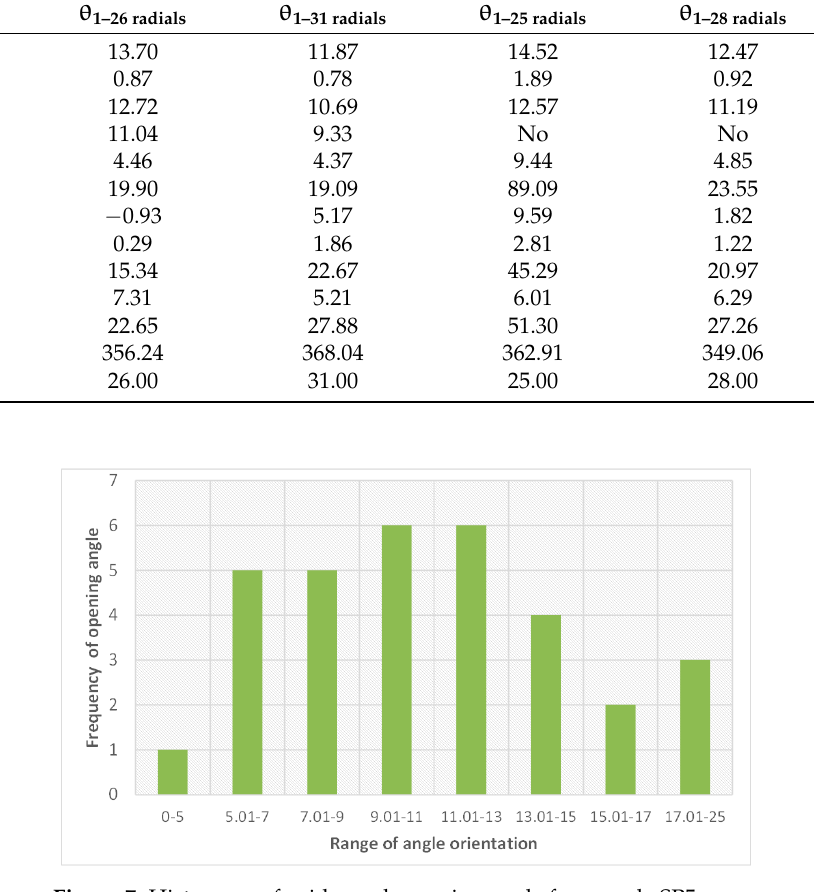
Extracted Data for the Opening Angle of Spider Web Radials from the Sampled Image